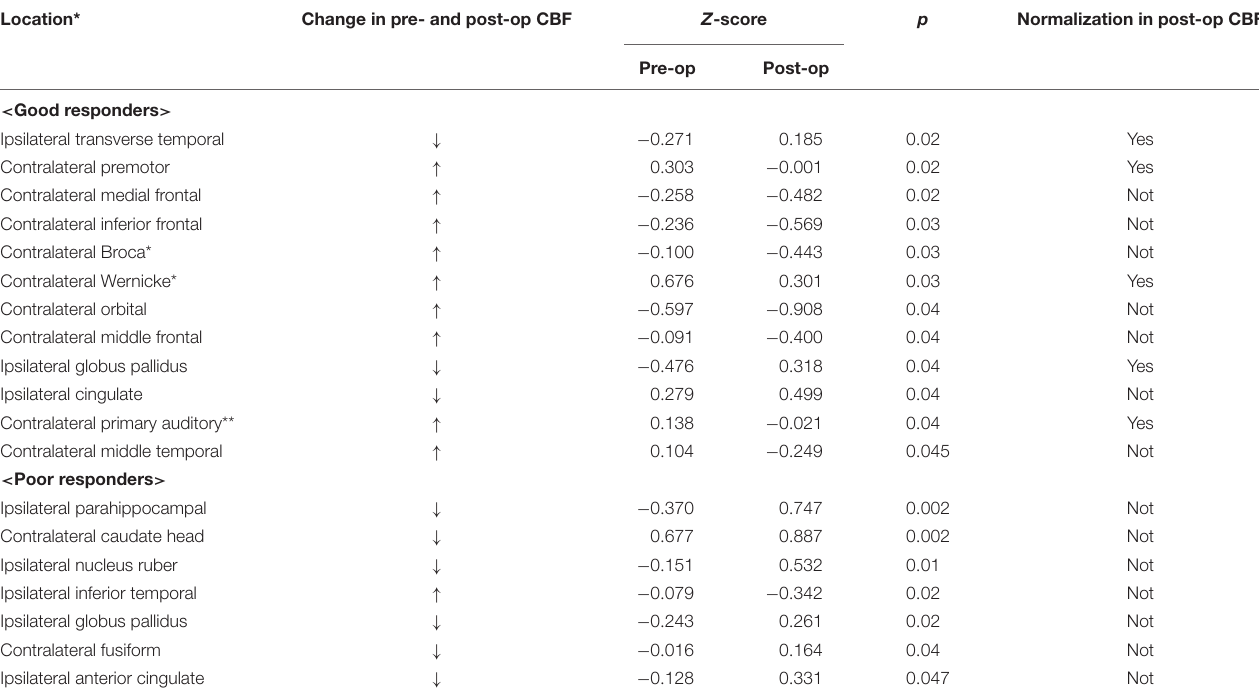
TABLE 2B | Comparison of Z -score between baseline and after unilateral deep brain stimulation of the globus pallidus internus (GPi-DBS) by brain perfusion single photon emission computed tomography (SPECT). Location* Change in pre- and post-op CBF Z